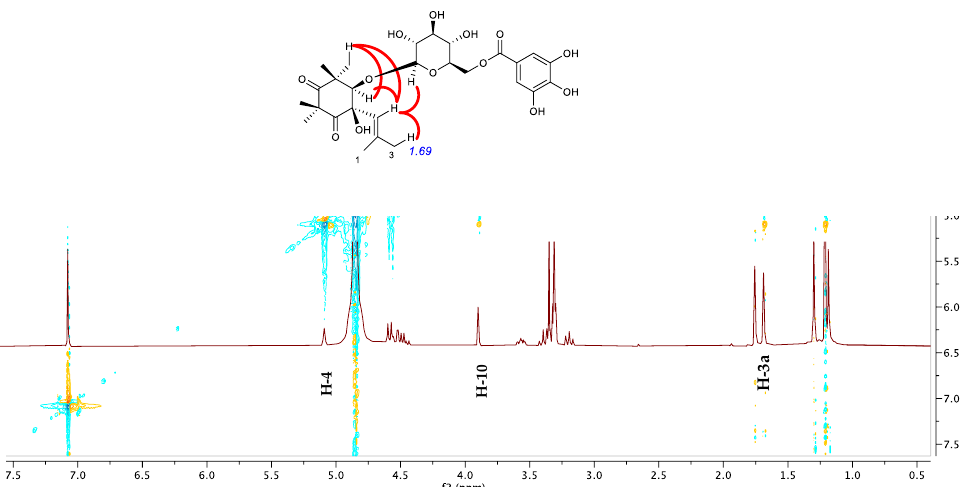
Figure 6. Key nOe correlation of compound 3 (top); expanded region of NOESY experiment of compound 3 .